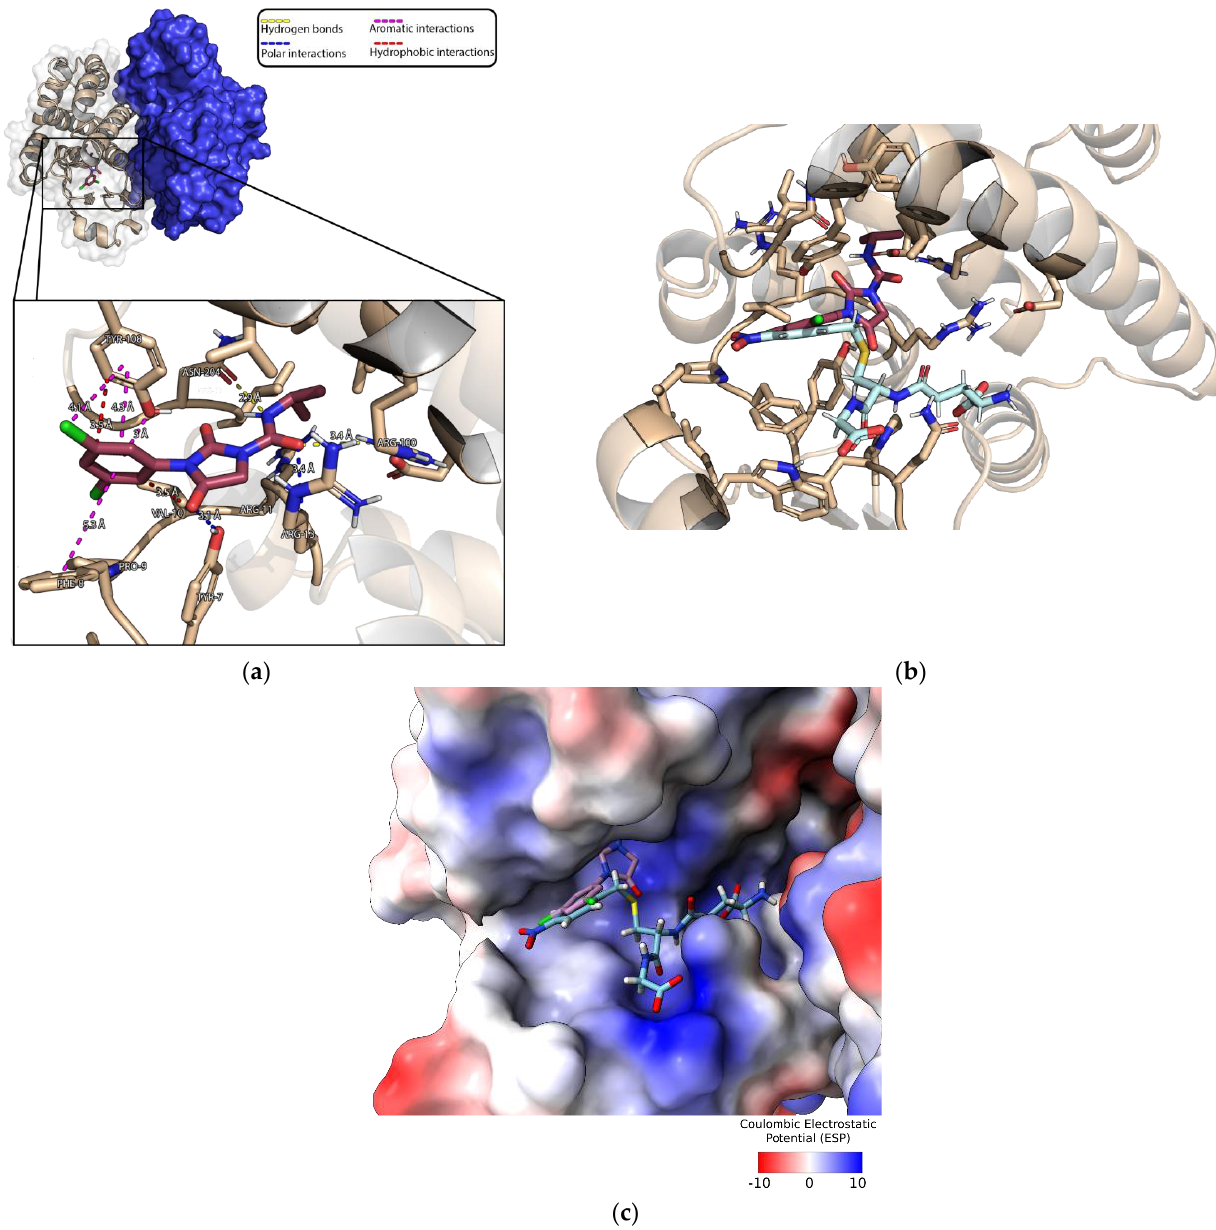
Figure 7. ( a ) Predicted favorable binding mode of iprodione in Mm GSTP1 − 1. Iprodione is shown in a stick representation. Close up: Side chains of the interacting amino acids are shown and labelled. Interactions were calculated using the Arpeggio web server [46]. The dashed lines represent interactions. ( b ) Superposition of bound iprodione and Nb-GSH in Mm GSTP1-1. Both ligands are shown in stick representation. Side chains of the interacting amino acids are shown. ( c ) Superposition of bound iprodione and Nb-GSH. Both ligands are shown in stick representation. The enzyme subunit is shown as the surface and colored according to the Coulombic electrostatic potential. Negative, positive, and neutral charges are shown as shades of red, blue, and white,